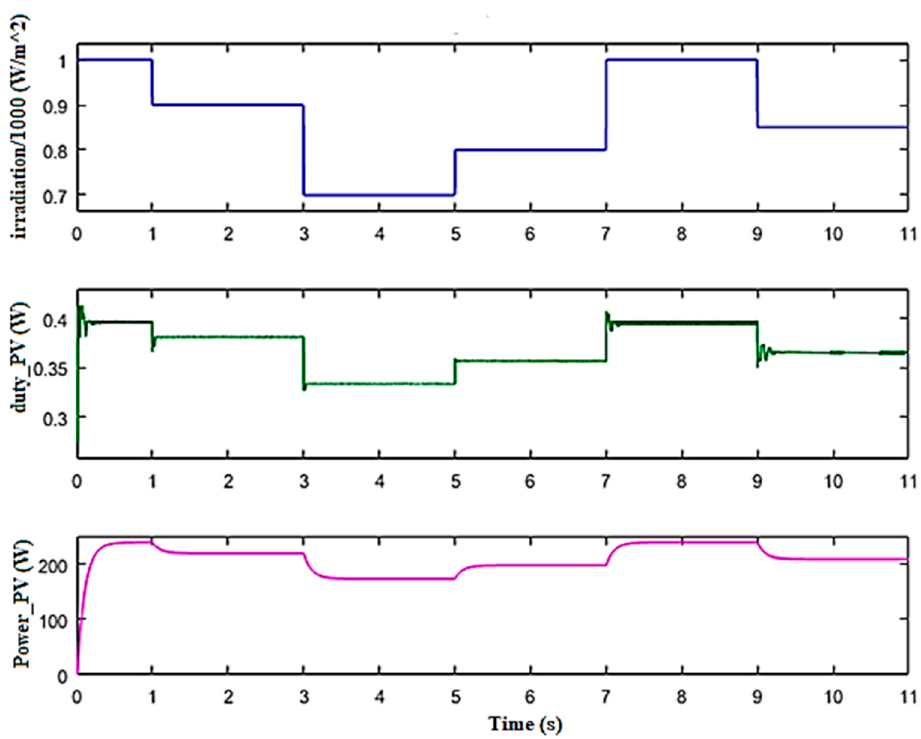
Figure 10. Waveforms of solar radiation, duty cycle, and power of the PVG.